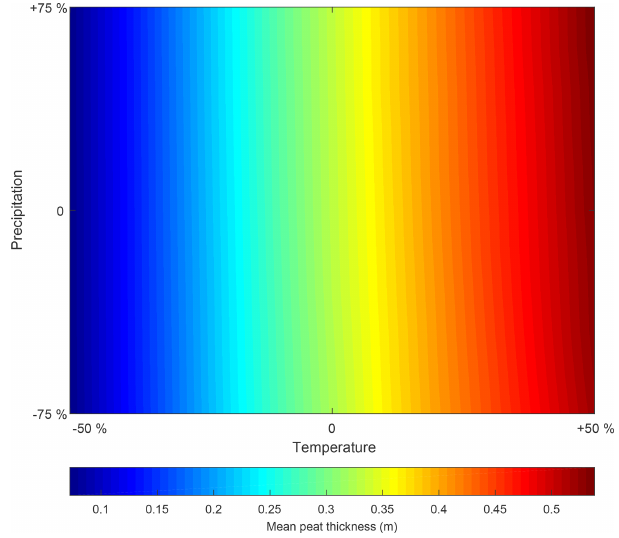
Figure 12. Mean peat thickness for all combinations of temperature and precipitation changes.